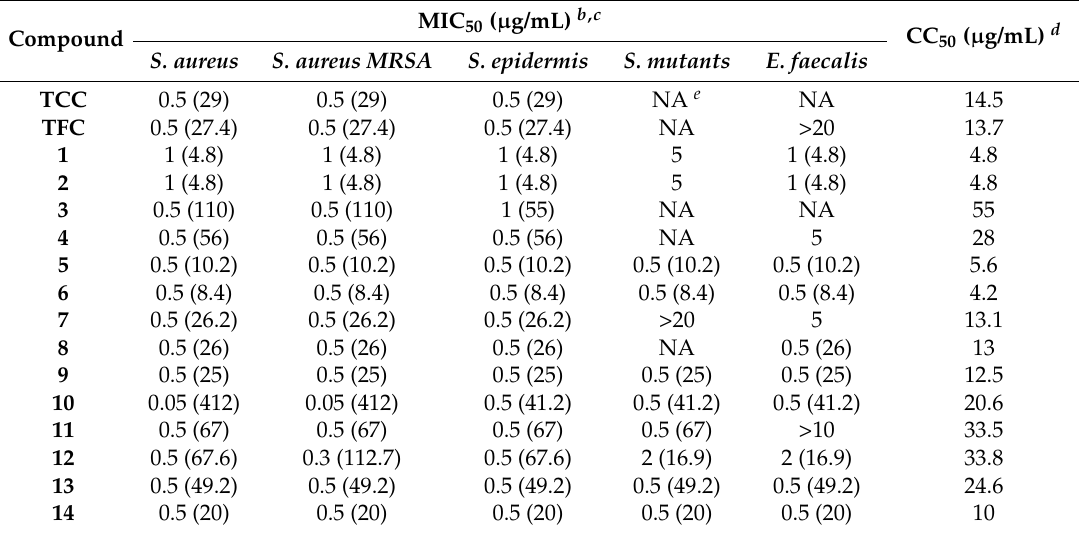
a For each tested compound, MIC 50 values are represented in the first row, whereas SI values are indicated in brackets. b MIC 50 values were determined against the following Gram-positive bacterial strains: Staphylococcus aureus (ATCC 12600); Staphylococcus aureus methyciline resistant ; Staphylococcus epidermis (ATCC 1798); Streptococcus mutants (ATCC 25175); Enterococcus faecalis (ATCC 19433). c All the compounds were inactive against two Gram-negative bacterial strains: Escherichia coli (ATCC 700926) and Pseudomonas aeruginosa (ATCC 15692). d CC 50 values were